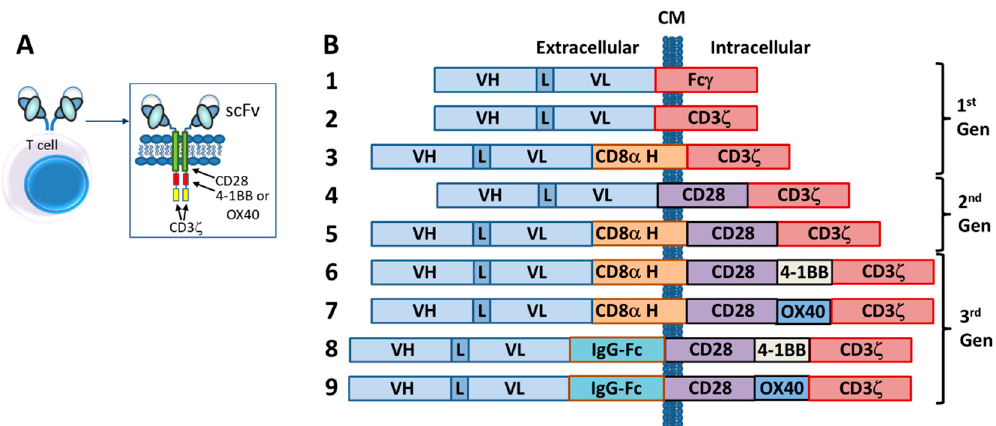
Figure 3. Generations of CAR-T cell therapeutics. Generations of CAR-T cell therapeutics as described in the text. ( A ) Generalized drawing of a CAR-T showing the fusion of the scFv to the transmembrane domain and intracellular activation domains. ( B ) Drawing depicting examples of first generation (1–3), second generation (4, 5) and third generation (6–9) CAR-T constructs as described in the text.